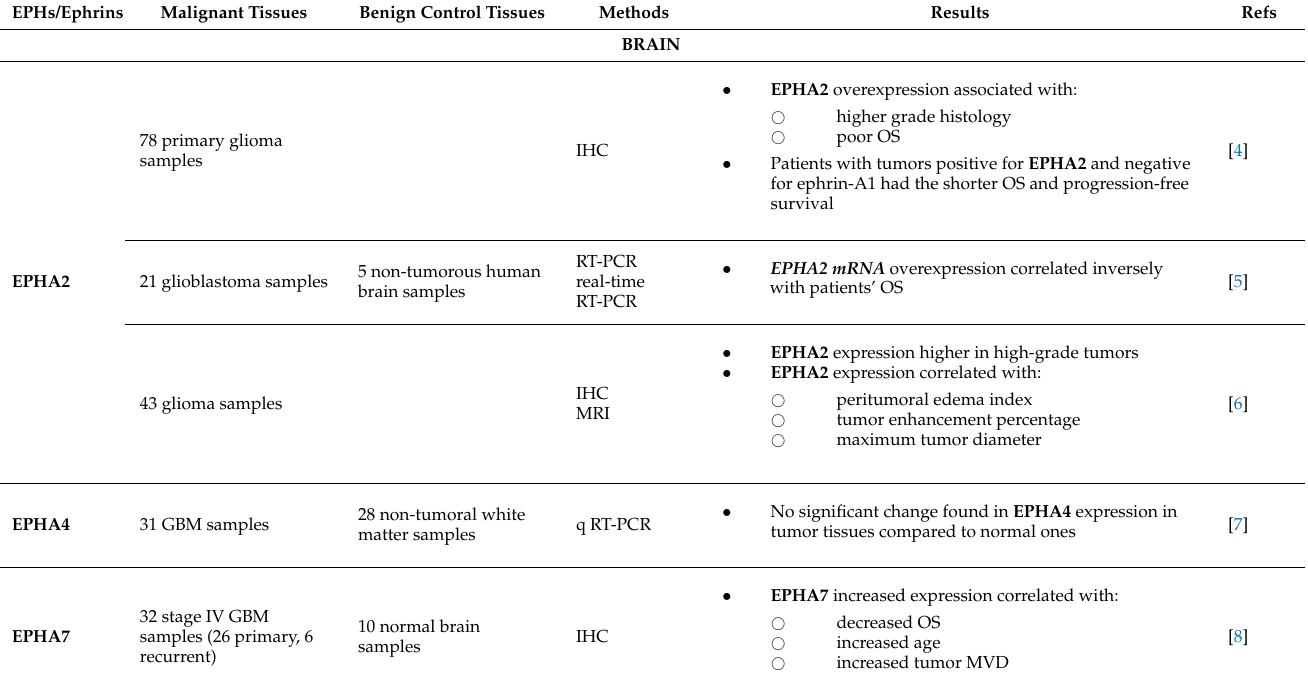
Table 1. EPHs/ephrins (bold) studied in solid tumors of head and neck and correlations with clinicopathological parameters. EPHs/Ephrins Malignant Tissues Benign Control Tissues